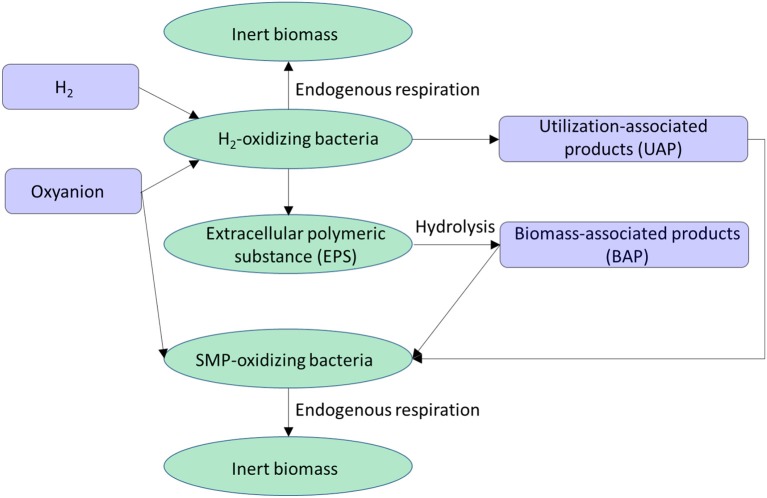
Interaction of the four biomass species (ellipses) via four dissolved chemical species (rectangles) in a H2-based biofilm.